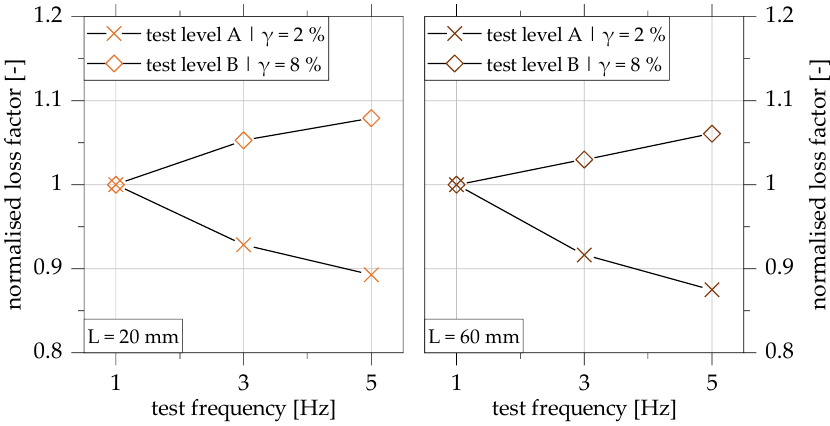
Figure 9. Influence of test frequency on the loss factor for overlap joint configuration 2 (t adh = 5.8 mm) with overlap lengths of 20 mm ( left ) and 60 mm ( right ) in test levels A and B; plot normalised to the loss factor at test frequency of 1 Hz based on [22].